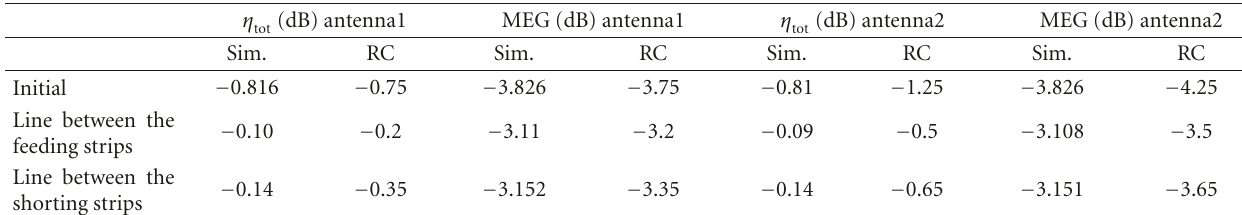
Table 2: MEG ratio of the antennas for all the prototypes at f = 2GHz. Initial 1,12 Line between the feeding strips 1,07 Line between the shorting strips